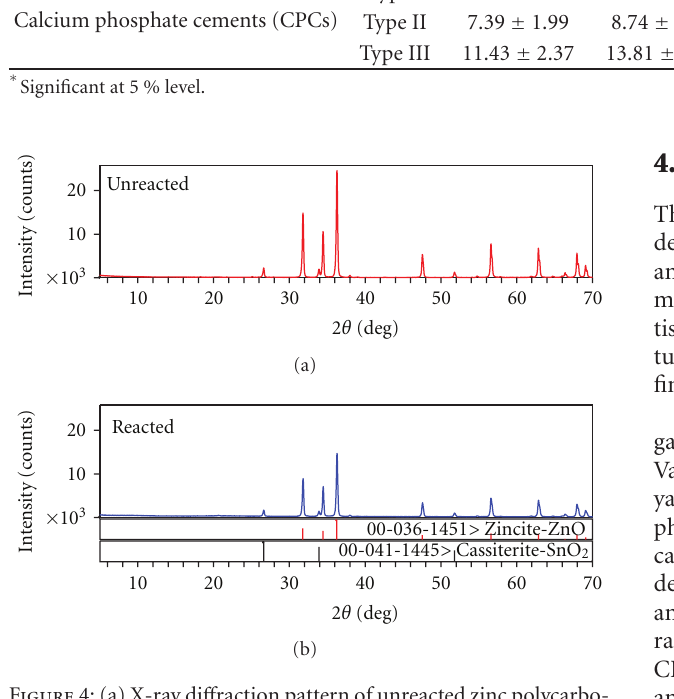
Figure 4: (a) X-ray di ff raction pattern of unreacted zinc polycarbo- xylate powder. (b) X-ray di ff raction pattern of set zinc polycarboxy- late